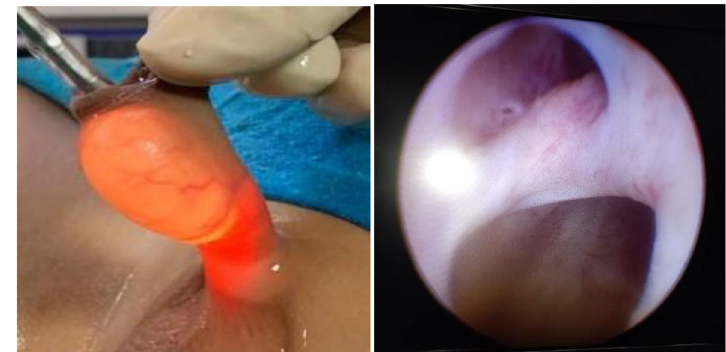
Fig. 4 Cysto-urethroscopy (case 7) showing “orange bulb” sign with large ventral urethral